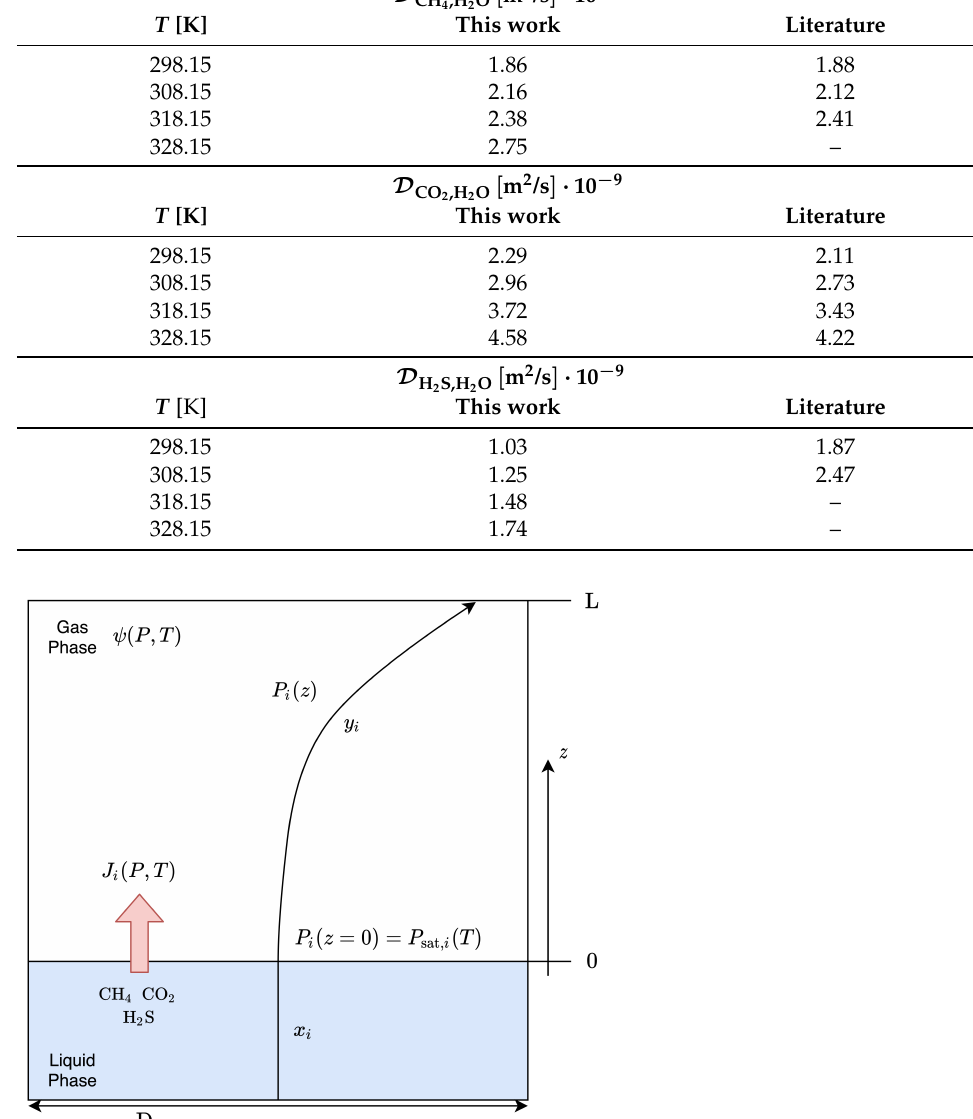
Figure 8. Schematisation of the material diffusion problem, evaluated as a stagnant film system ( z resembles the axis direction starting from the liquid interface towards the headspace of the